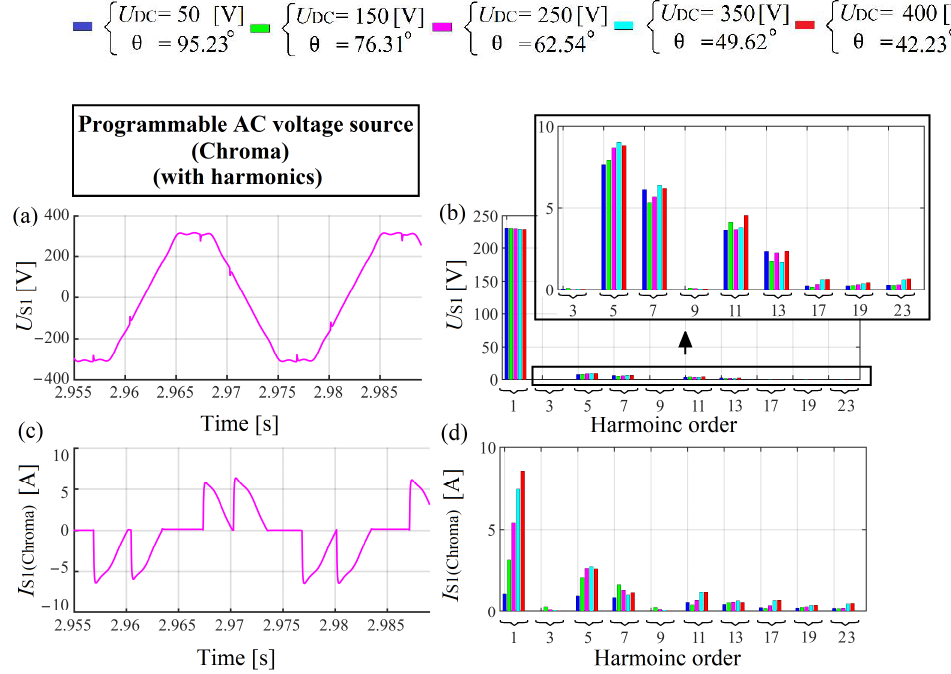
Figure 23. Waveforms and spectrums when the filter is not connected: ( a ) PCC voltage waveform with ( b ) its spectrum, ( c ) voltage source input current with ( d ) its spectrum (only the load is connected).